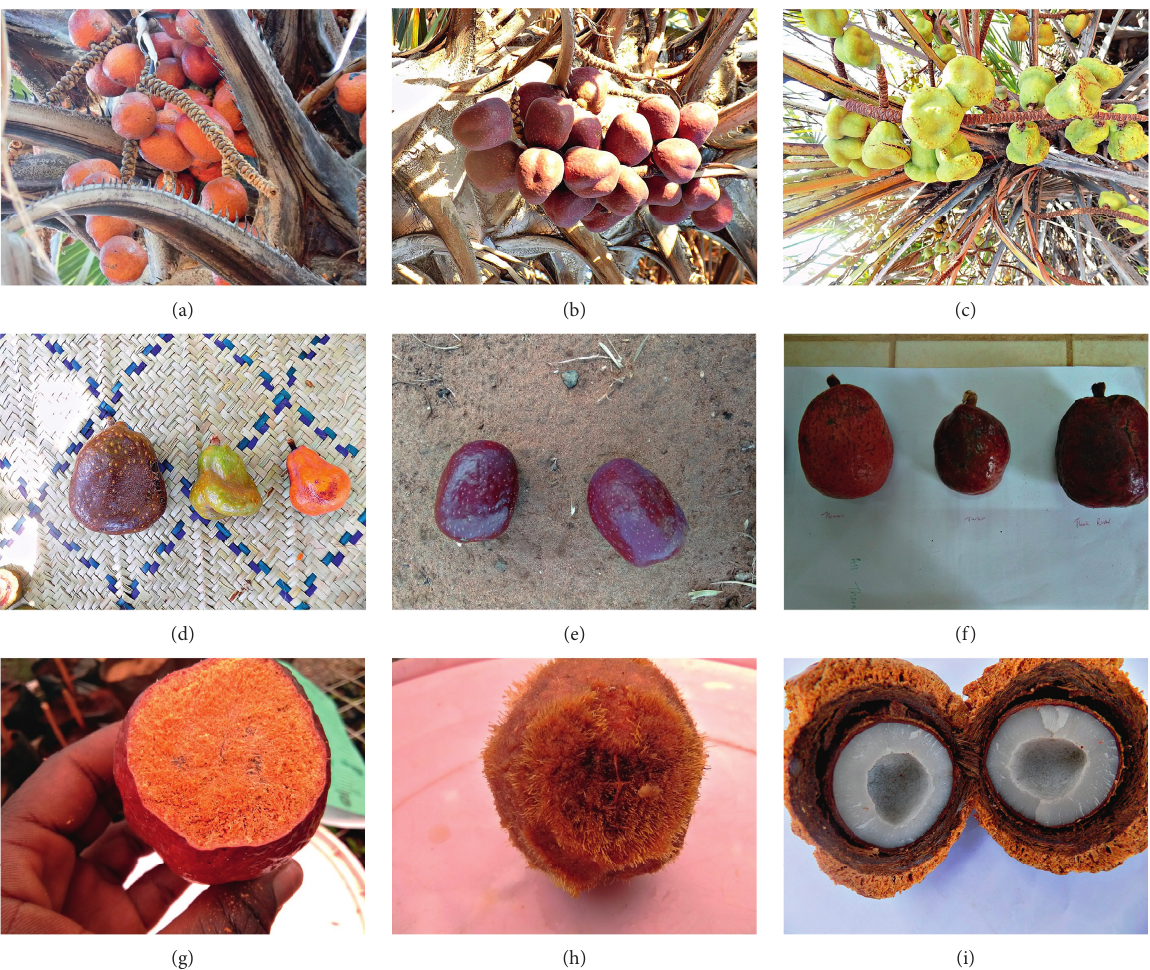
Figure 2: H. compressa fruit morphology in Kenya. (a) Mature doum palm fruits that are orange in colour in Tharaka. (b) Immature doum palm fruits maroon in colour in Turkana. (c) Immature doum palm fruits green in colour in Kwale. (d) Fruit morphology in Kwale: from left to right: round oblong shape (brown in colour), ovate shape (green), and obovate shape (orange). (e) Immature doum palm fruits maroon in colour. (f) From left to right: fruits from Tharaka Nithi, Turkana, and Tana River. (g) Orange mesocarp of the doum palm fruit. (h) Hairy mesocarp of doum palm fruit. (i) Cross section of the doum palm